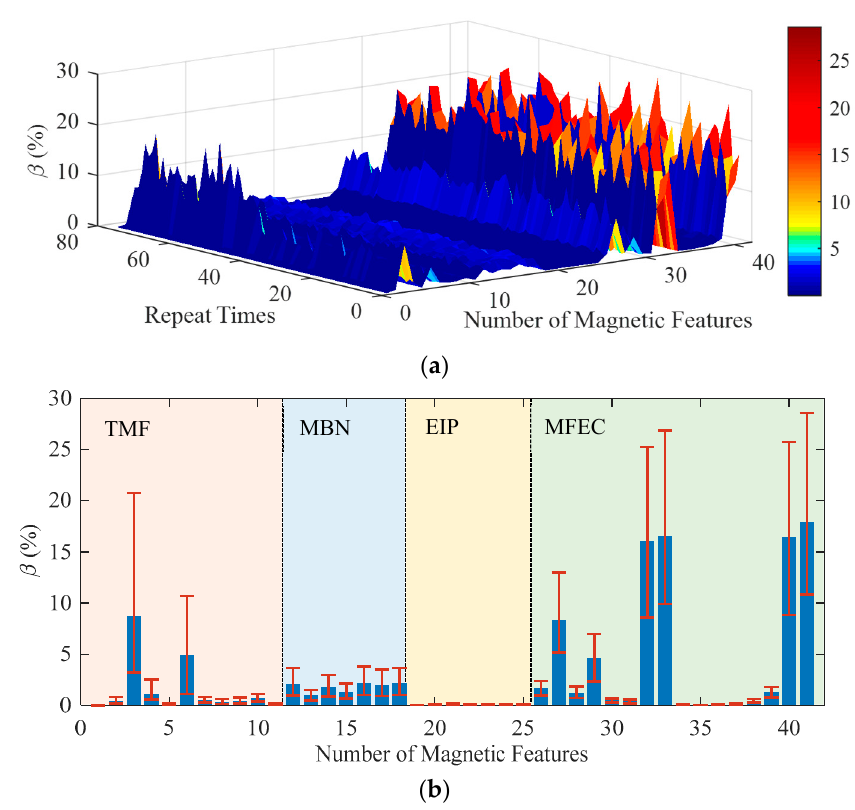
Figure 5. The coefficient of variation of the magnetic features estimated under static conditions. ( a ) and ( b ) demonstrate the estimated results in 3D and 1D, respectively.